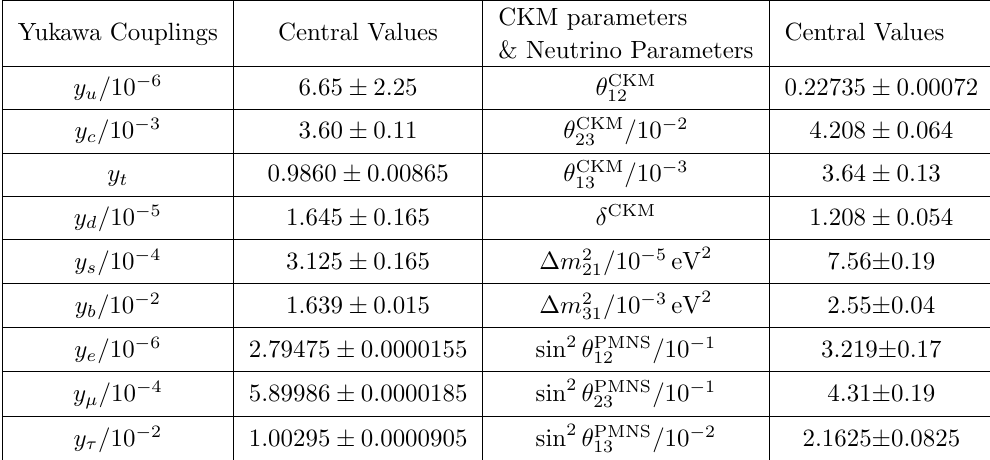
Table 1 . Values of observables in the charged fermion sector at M Z scale, taken from ref. [37]. Here experimental central values with associated 1 (cid:27) uncertainties are quoted. The masses of the charged fermions are given by the relations m i = v y i with v = 174 : 104 GeV. For neutrino observables, the low energy values are taken from ref.